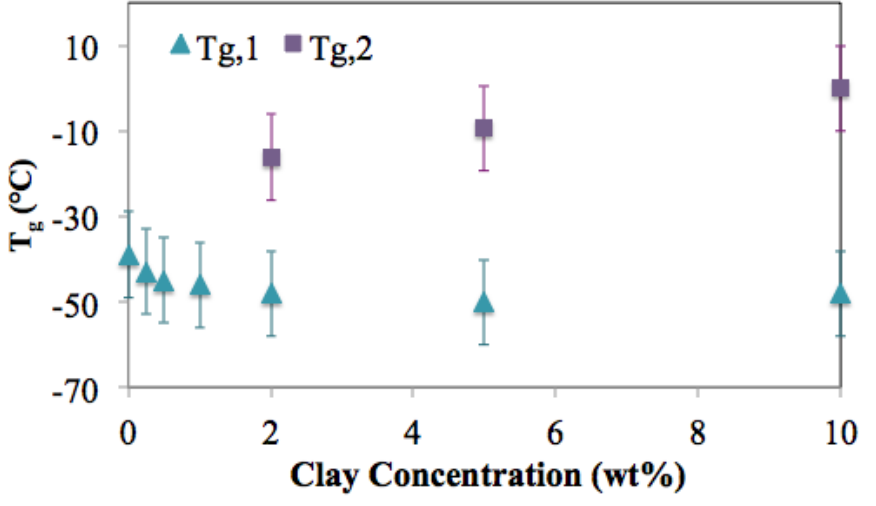
Figure 10. Dependence of the glass-transition temperature of nanocomposites on the wt.% clay, showing the variation of the two T gs with composition. At lower clay wt.% of < 2. T g,1 predominates and it is attributed to the neat matrix and matrix containing well dispersed clay. At higher wt.% clay, ≥ 2, both T g,1 and T g,2 are present. T g,2 is attributed to nanocomposite aggregates and clay-matrix interfacial phenomenon.